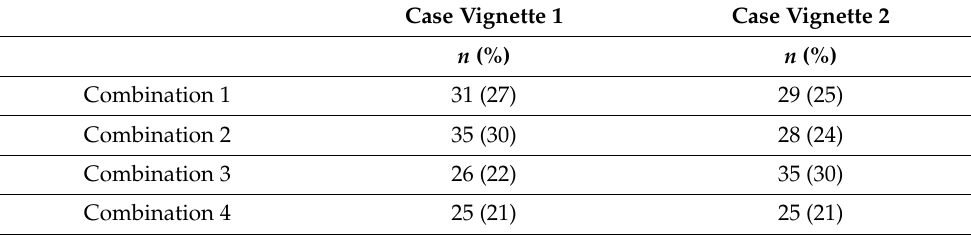
Table 1. Distribution of the vignette combinations of the returned questionnaires ( n =